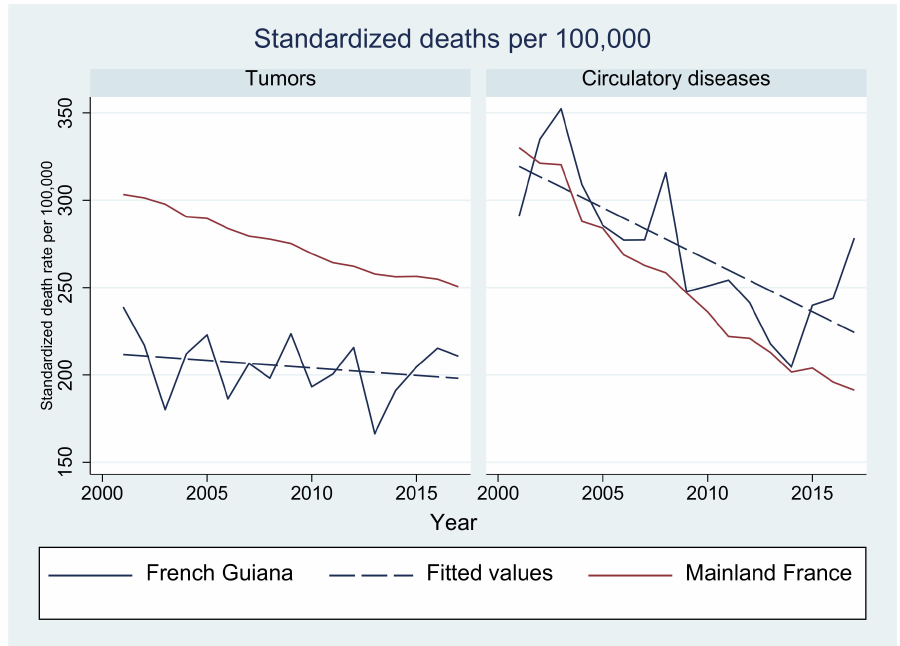
Figure 5. Evolution of the standardized death rate for tumors and circulatory diseases: French Guiana vs. mainland France.